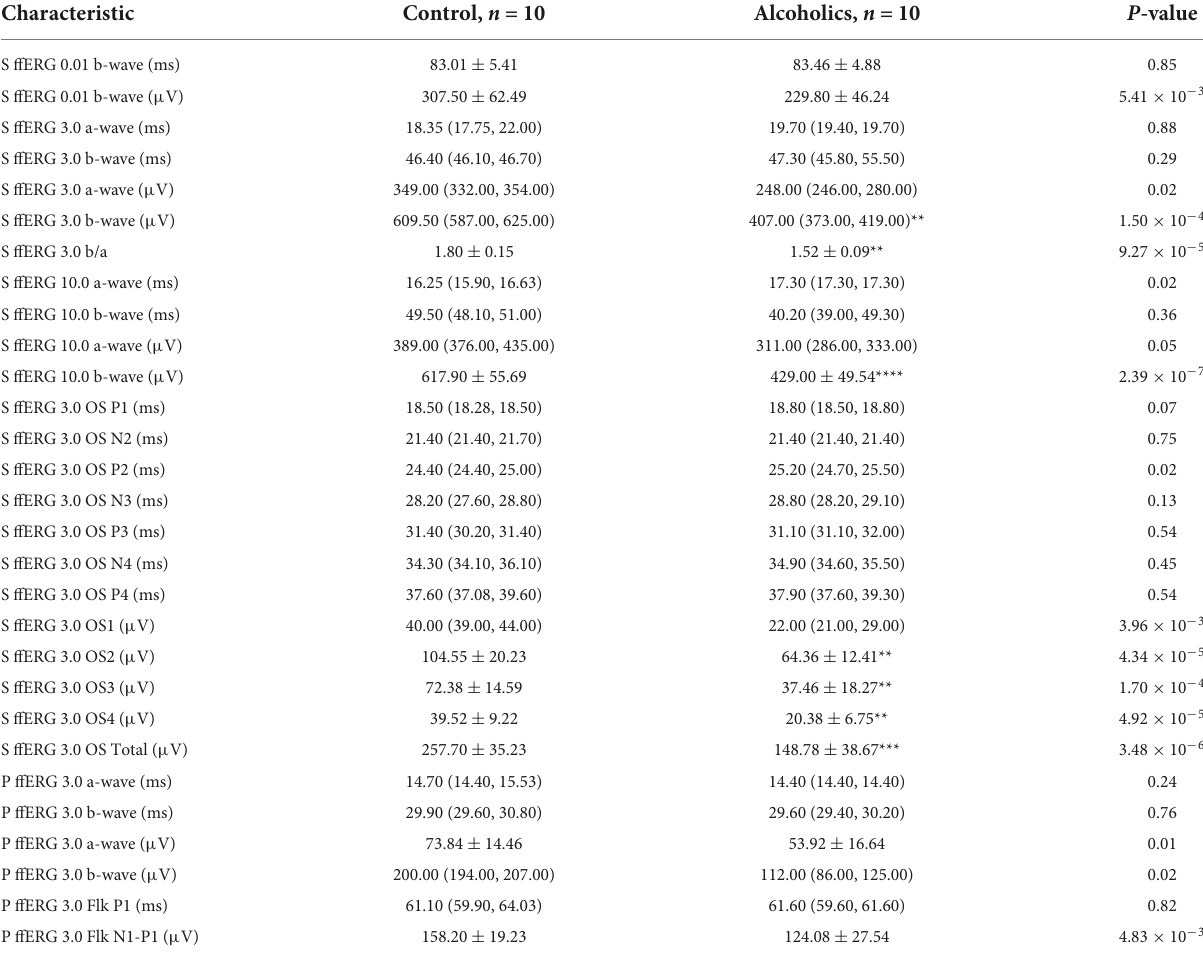
TABLE 2 ffERG components